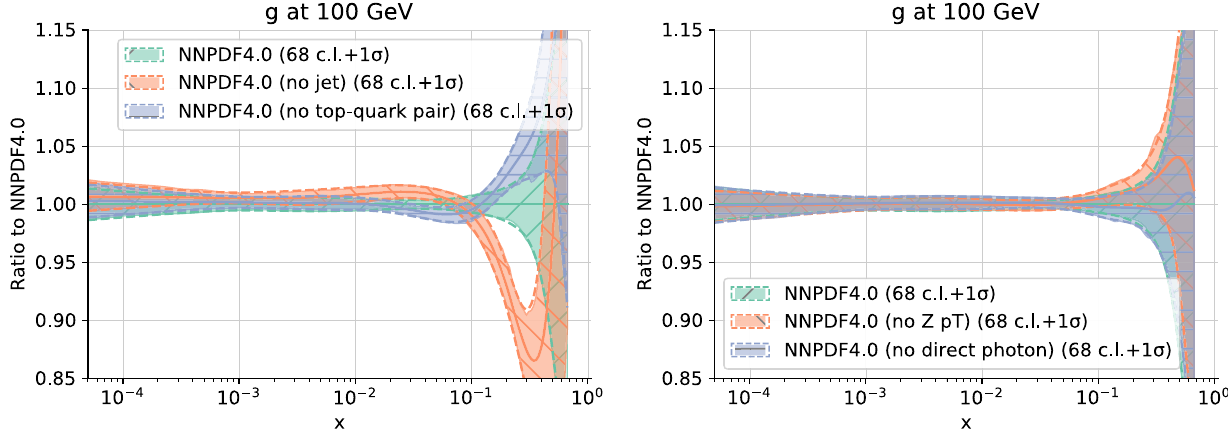
Fig. 37 The gluon PDF obtained removing single-inclusive jet and dijet data or top pair data (left), or Z p T data or direct photon data